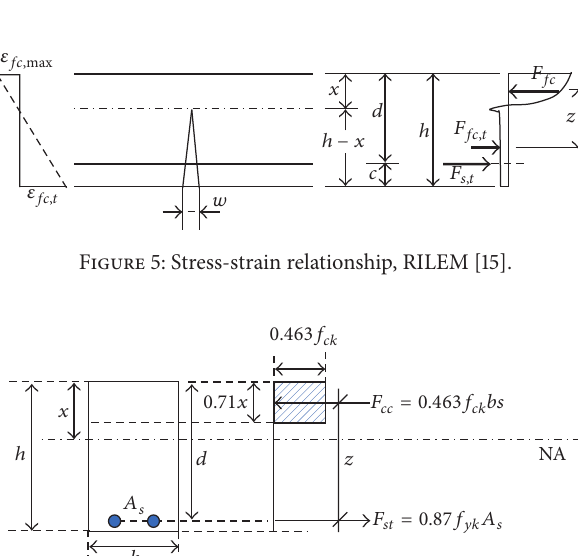
Figure 4: Test setup and details for R-SC-ECC beams.